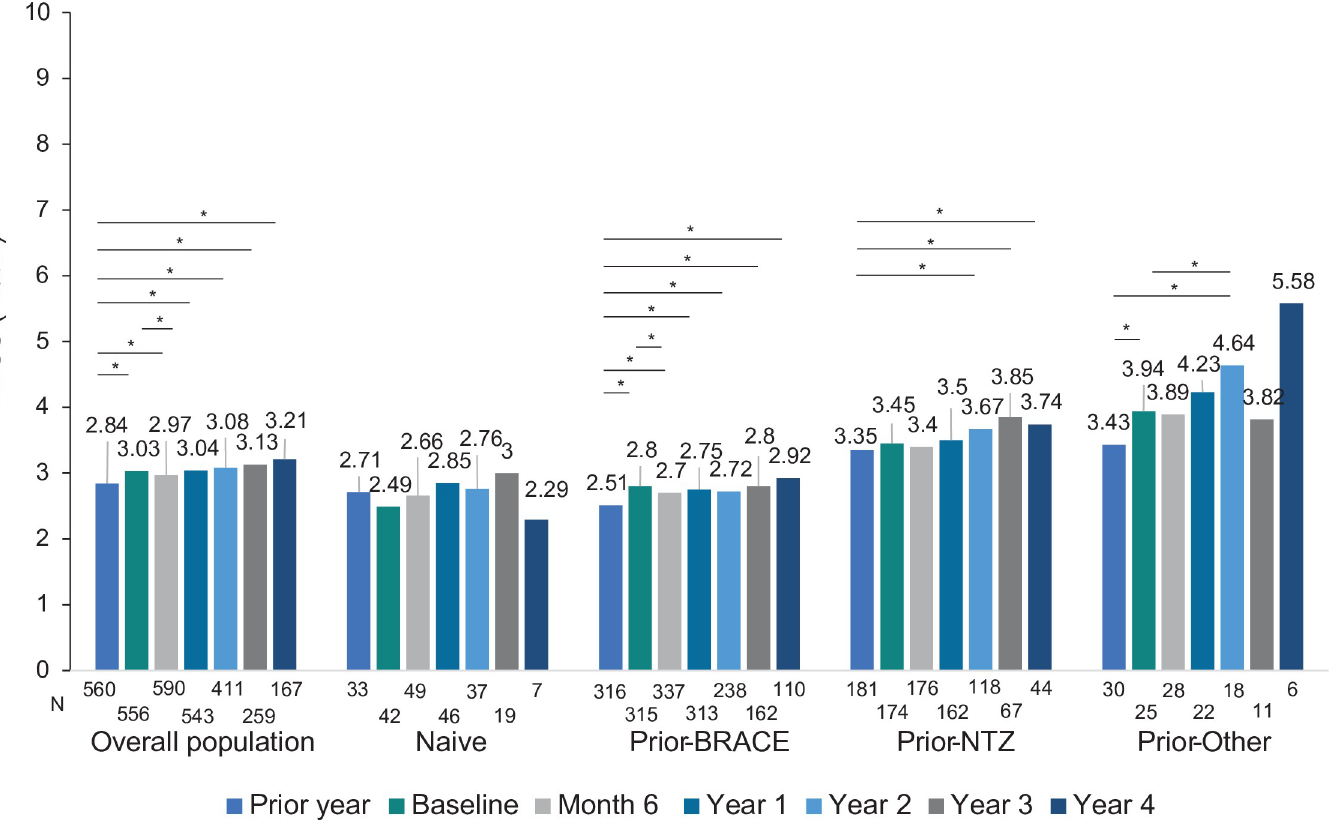
Fig 2. Expanded Disability Status Scale evolution in the overall population and prior treatment subgroups. Abbreviatures : BRACE: Betaseron (interferon beta-1b sc), Rebif (interferon beta-1a sc), Avonex (interferon beta-1a im), Copaxone (Glatiramer acetate), and Extavia (interferon beta-1b sc); EDSS, Expanded Disability Status Scale; IQR, interquartile range; N: Number of patients with available data for EDSS at that visit; NTZ, natalizumab. � Significant (p < 0.05) paired comparation EDSS at month 6, year 1, year 2, year 3, and year 4 vs year prior to fingolimod and vs baseline are shown. Comparisons have been conducted considering the patients with EDSS data at both visits. Not significant comparisons are not